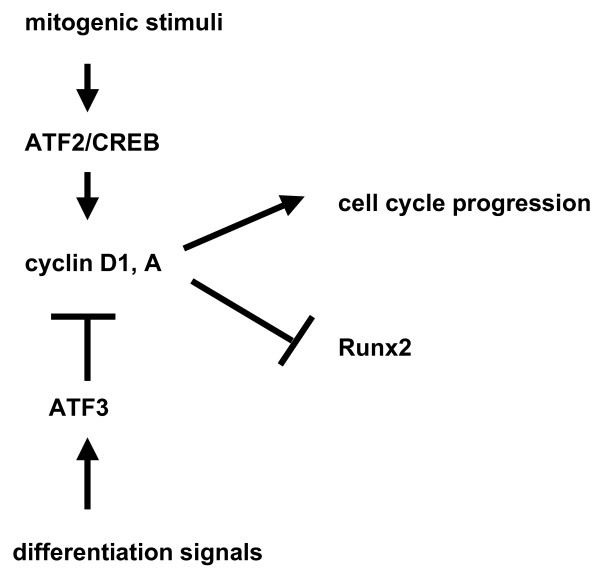
Model for ATF3 action in chondrocyte differentiation. We suggest that induction of ATF3 by differentiation stimuli antagonizes the CRE-dependent expression of cyclin D1 and cyclin A, which are induced by mitogenic stimuli through ATF2 and CREB. Reduced cyclin-dependent kinase activity and hypophosphorylation of pocket proteins in response to ATF3 upregulation then results both in cell cycle exit and in increased activity of Runx2, promoting chondrocyte differentiation.